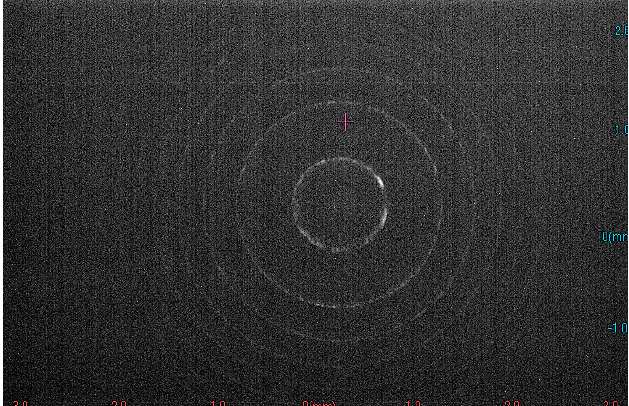
Figure 5. Typical interference pattern of the single-frequency 1178 nm Raman laser.